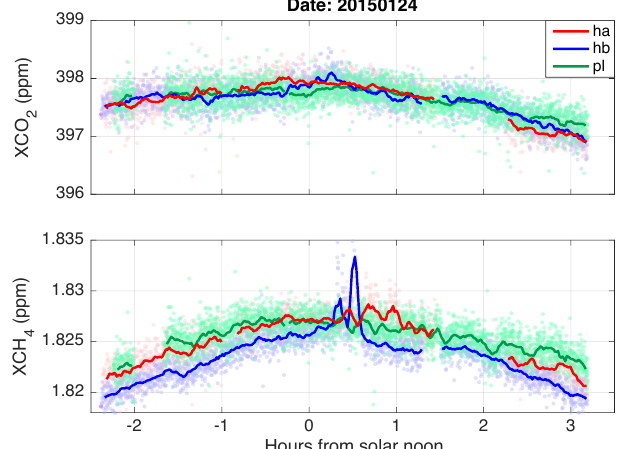
Figure 10. Observed X CO at ha, hb, and pl sites on 24 January 2015; the transient peaks in X CH are not observed for X CO 4